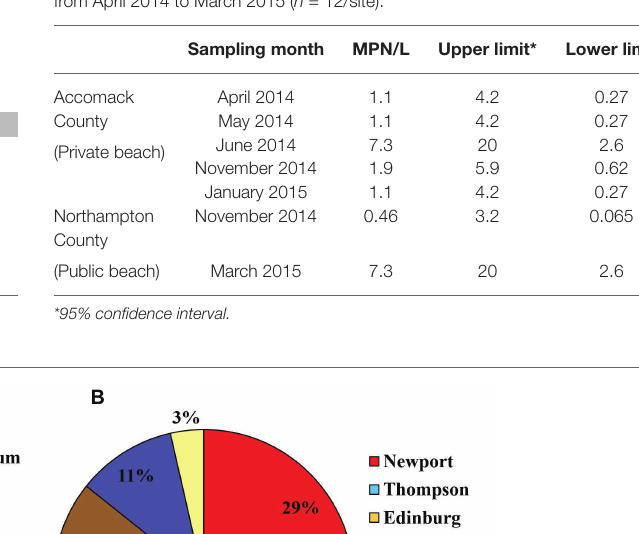
TABLE 2 | Prevalence and most probable number (MPN) values of S. enterica in Chesapeake Bay water at two detection sites on the Eastern Shore of Virginia from April 2014 to March 2015 ( n =